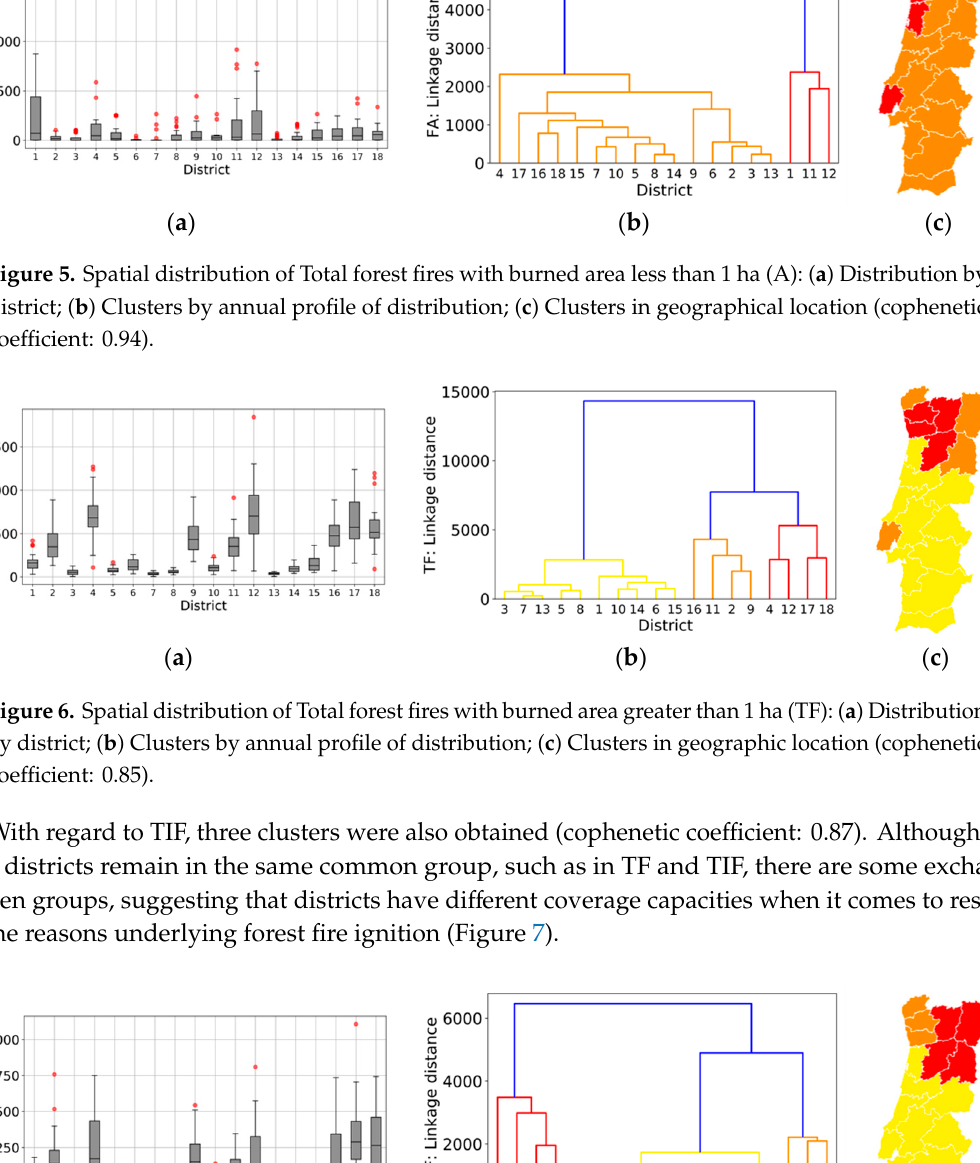
( c ) Figure 3. Spatial distribution of Total occurrences (TOc): ( a ) Distribution by district; ( b ) Clusters by annual profile of distribution; ( c ) Clusters in geographic location (cophenetic coefficient: 0.88). Regarding the occurrences classified as fire (A > 0) (Figure 4), the results of the analysis are similar to those for total occurrences. The clusters have the same groups of districts. The annual averages and respective standard deviation are: 5356 ± 1677, 2080 ± 921 and 592 ± 401, respectively, for the different clusters. The cophenetic coefficients are also similar (0.87), meaning that clustering analysis and the dendrogram are reliable techniques to use since they keep the pairwise distances between the original unmodeled data. ( a ) ( c ) Figure 4. Spatial distribution of Total burns (TB: ( a ) Distribution by district; ( b ) Clusters by annual